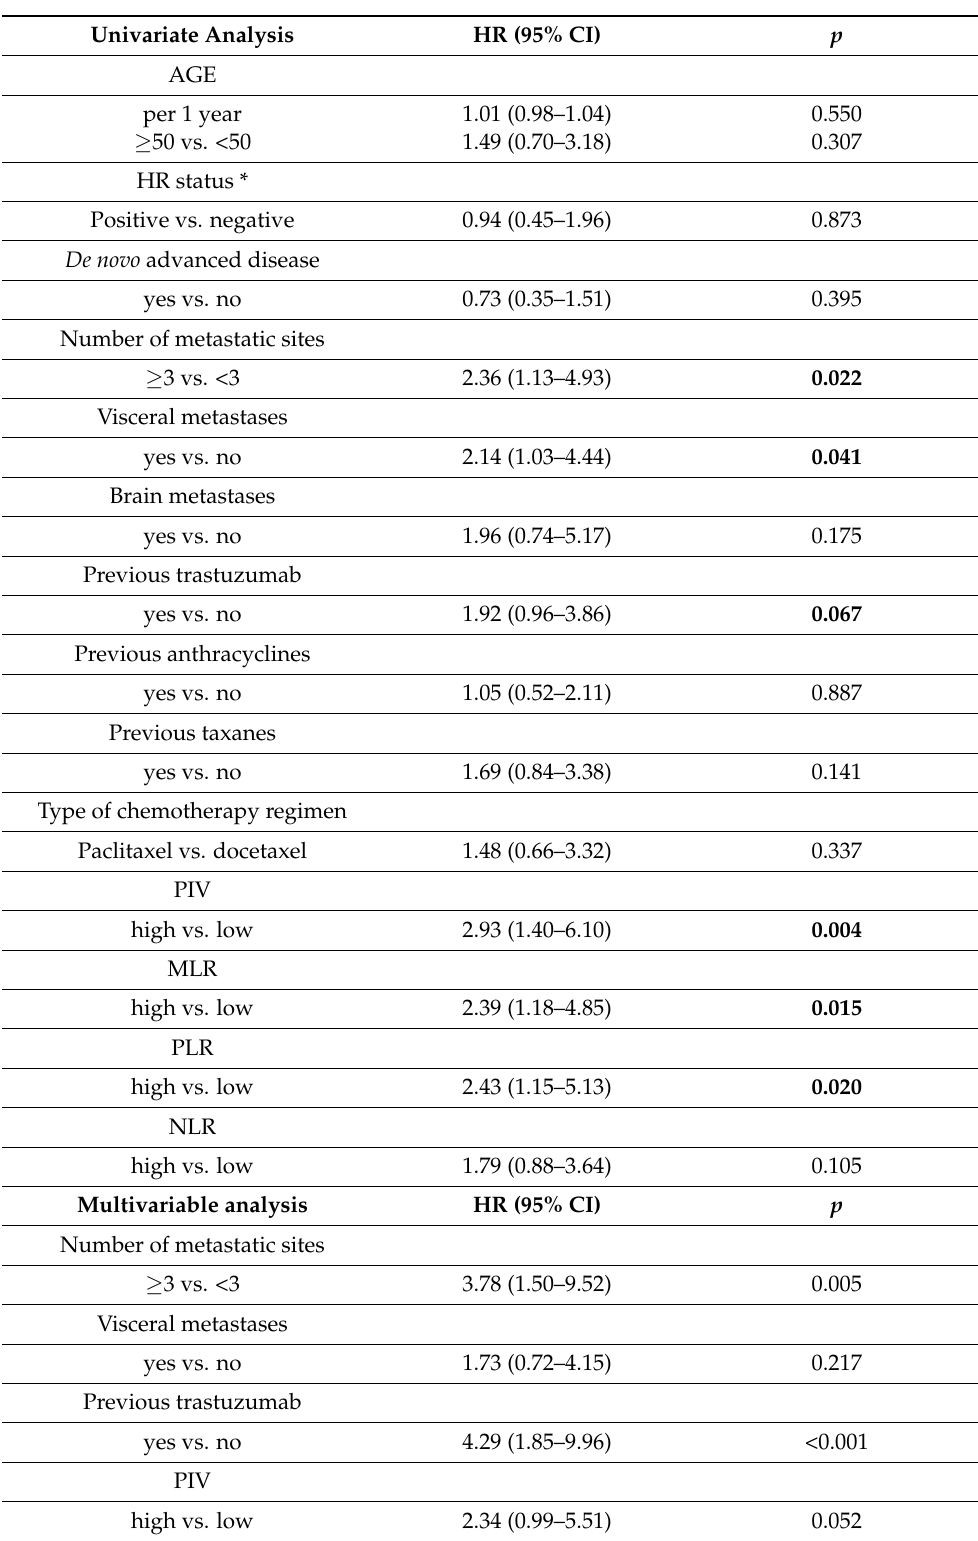
Table 2. Univariate and multivariable Cox proportional hazards model for